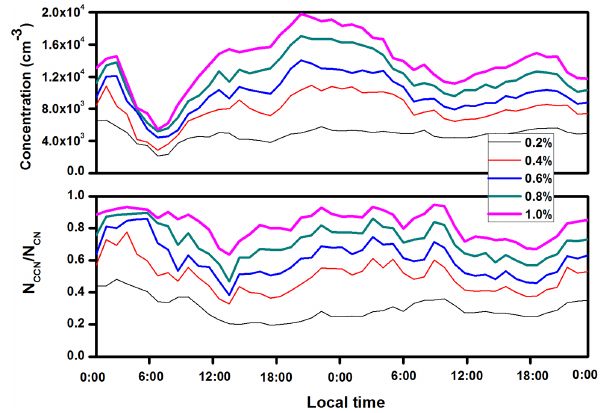
, NO − and NH + concen- Figure 9. Series of 1h mean CCN concentration and CCN/CN on 4 3 4 3 and 4 April 2012.